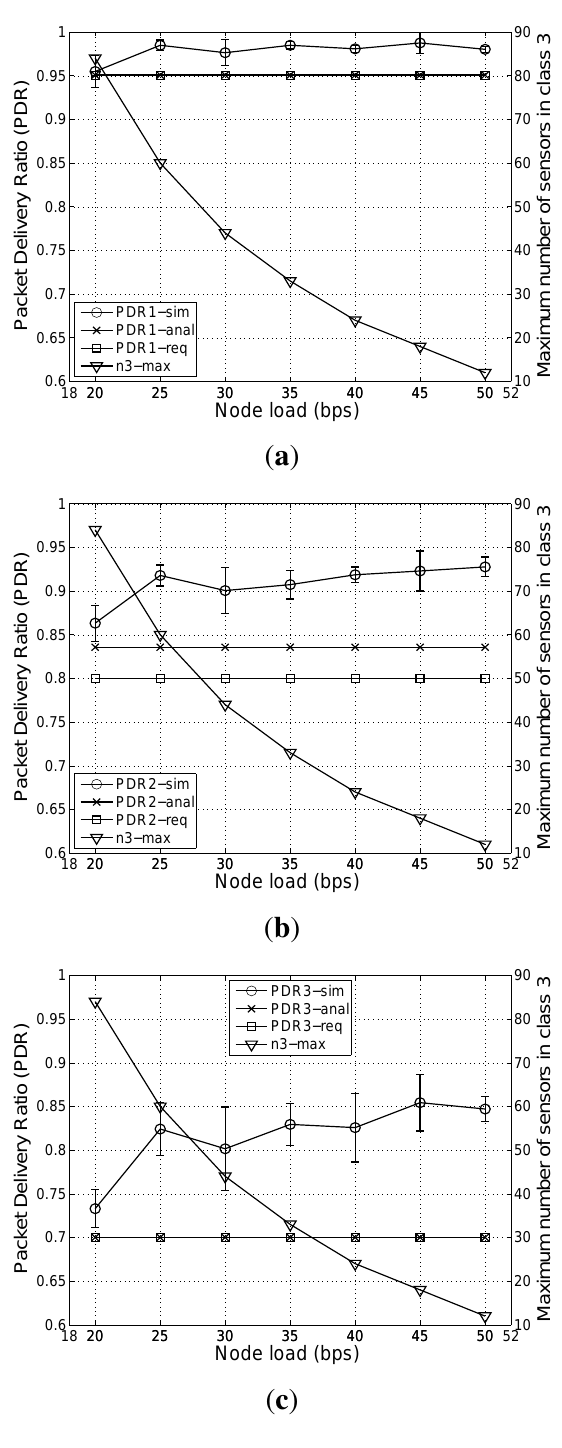
Figure 3. Effects of node load on the PDR (mean +/- standard deviation) achieved from the greedy algorithm and from simulations, and the maximum number of nodes in class Q n = 5, n = 15. ( a ) For class Q 1 2